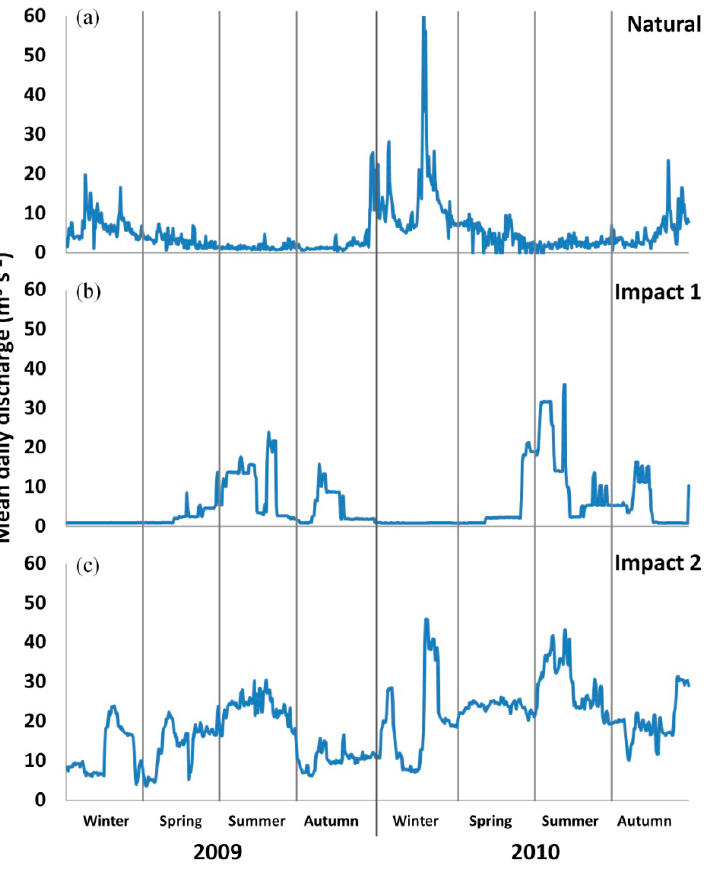
Figure 2. Flow variation (mean daily discharge; m 3 s − 1 ) at three representative fluvial sectors in the study area. Repre-sentative flow regimes were measured at three gauging stations: ( a ) Natural flow regime at the upper part of the Mundo River, ( b ) Impact 1 just downstream of the Cenajo reservoir, and ( c ) Impact 2 downstream of the La Mulata dam (see location in Figure 1). Flow discharge data were obtained from the Segura Hydrographic